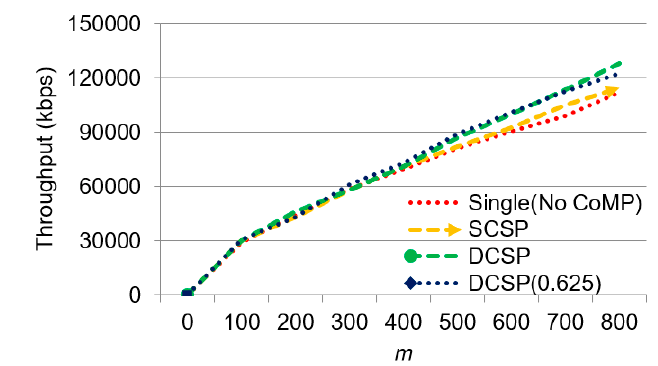
Figure 12. The effect of ᶆ on throughput.